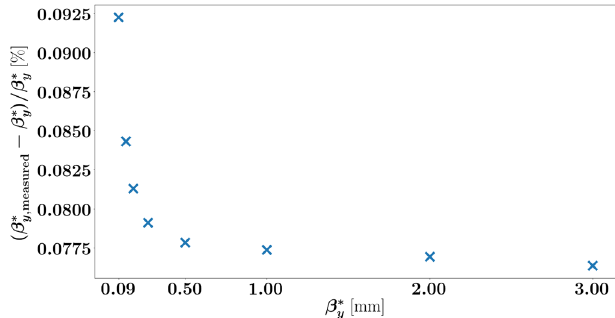
FIG. 8. Comparison of tune shifts for different β (cid:1) y calculated using Eq. (3) and taking into account the fringes by using Eq. (34). The calculations are based on the values for the LER magnet QC1LP, with Δ KL=KL ¼ 2 × 10 − 5